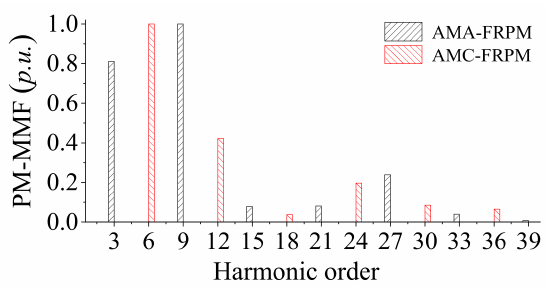
Figure 4. PM-MMF harmonic distribution for AM-FRPM machines.